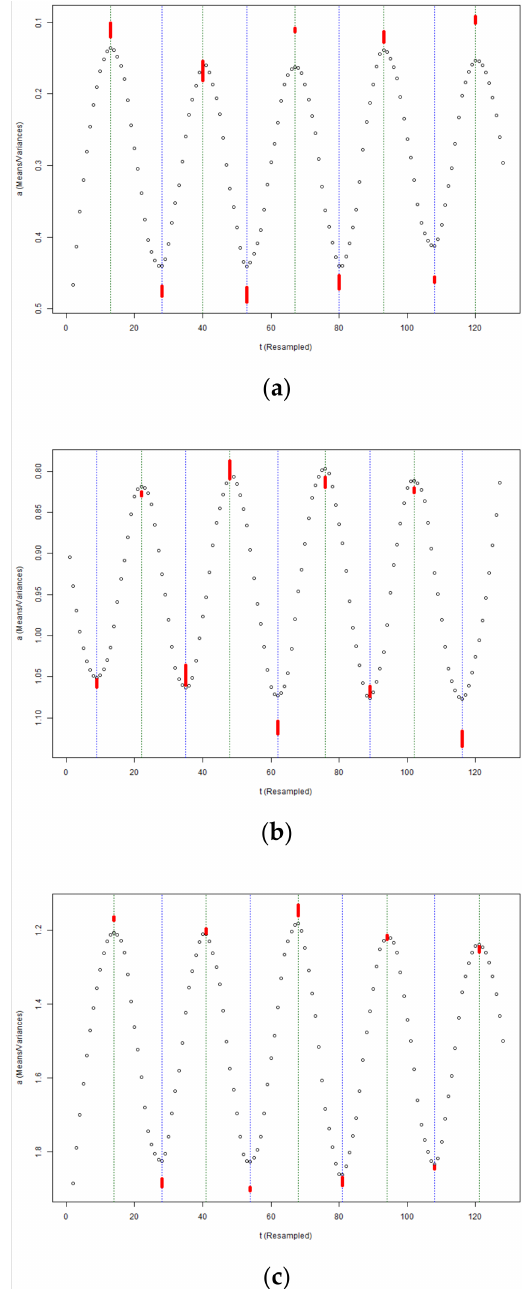
Figure 10. Means and peak/valley variances of resampled data for the 2.0-blade turbine. ( a ) Based on datasets recorded along the X axis with no wind imposed. ( b ) Based on datasets recorded along the Y axis with no wind imposed. ( c ) Based on datasets recorded along the Z axis with no wind